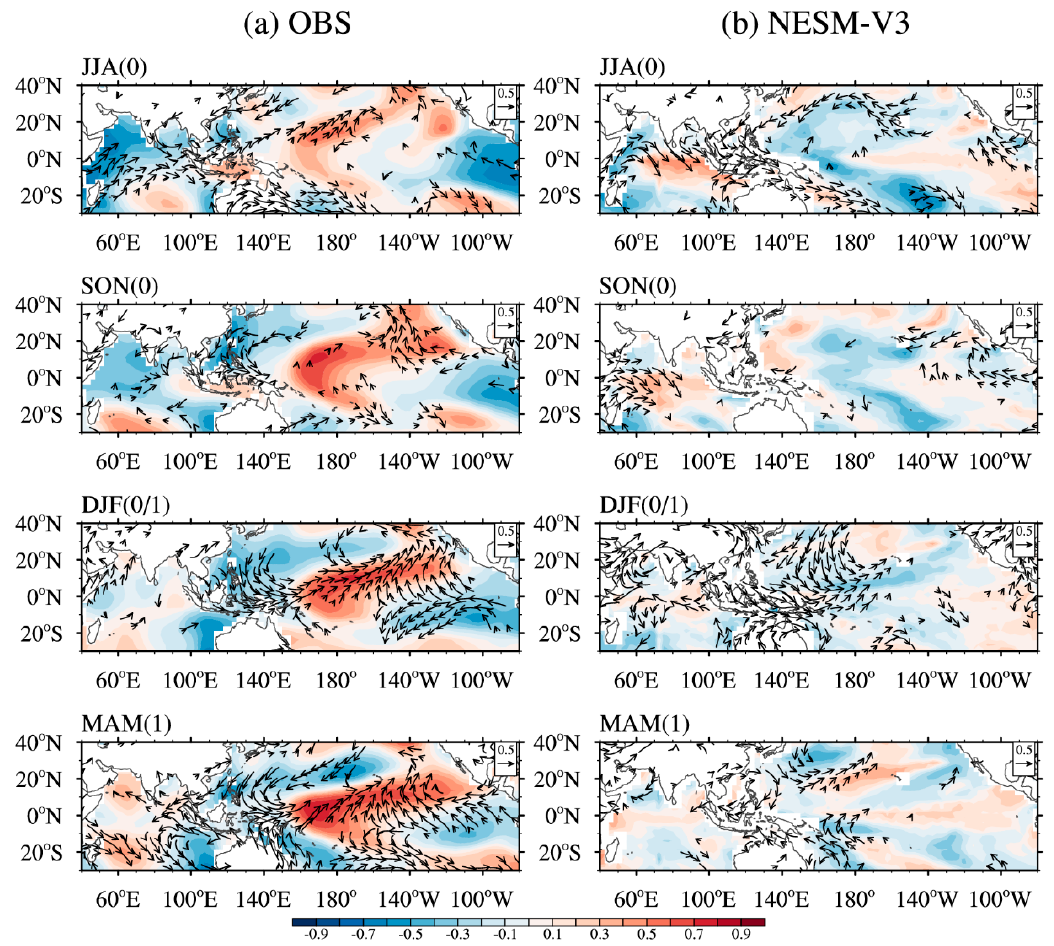
Figure 7. Same as in Figure 5, except for the second SEOF.